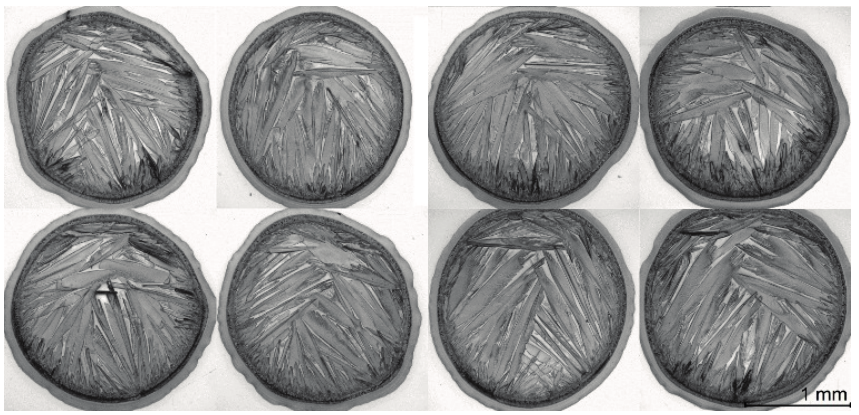
Figure 7. Microscope images of nine D1_PAMS drops indicating the variance in crystallization repeatability.